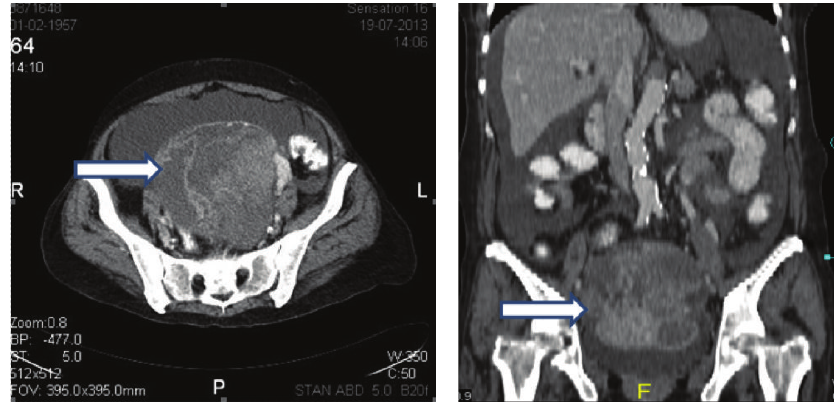
Figure 1: Abdominal computerized tomography revealed a complicated pelvic mass of ovarian origin (arrows).